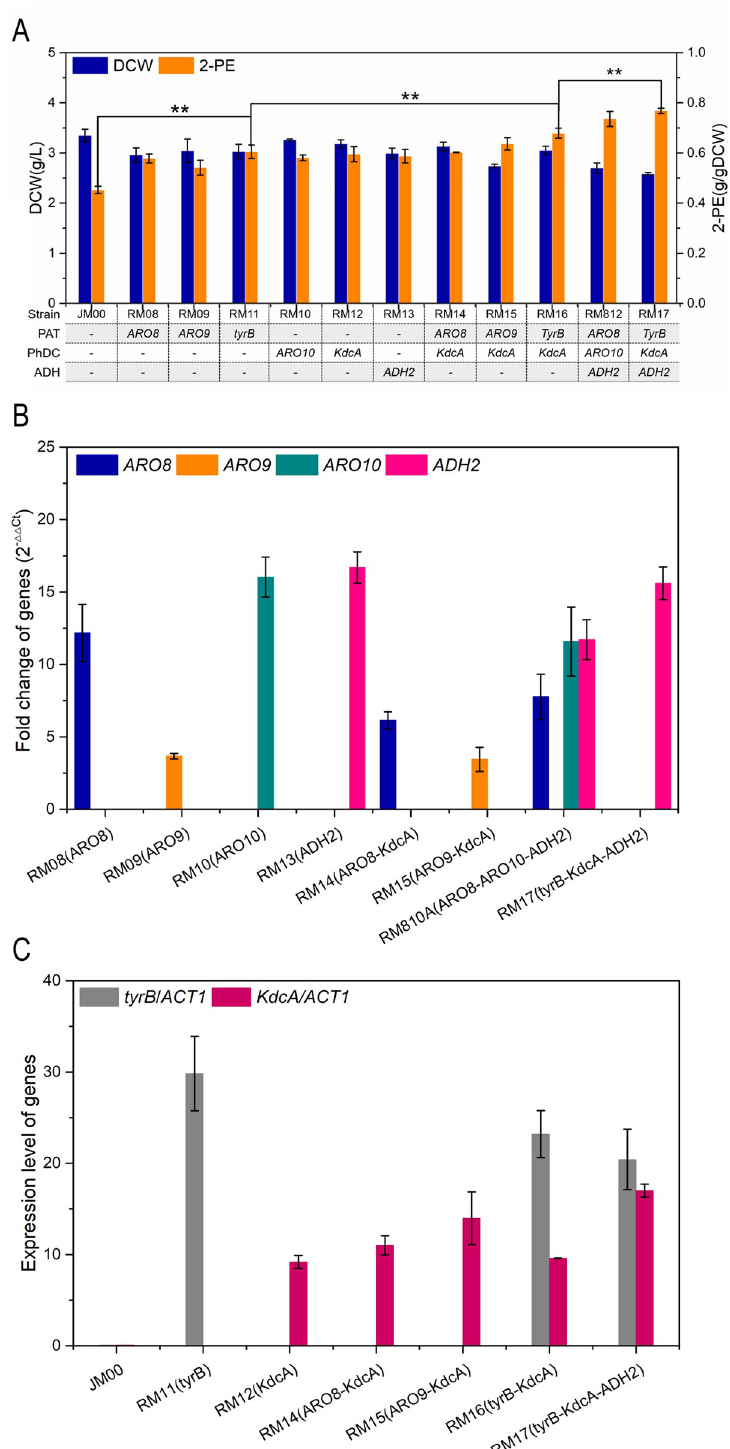
Fig 4. Effective expression of individual key enzyme and fusion protein in Ehrlich pathway. (A) Influence on cell growth and 2-PE production by overexpressing enzymes of Ehrlich pathway respectively. The gene types were listed under the bar graph. Enzyme abbreviations: PAT, phenylalanine transaminase; PhDC, phenylpyruvate decarboxylase; ADH, alcohol dehydrogenase. The mutant strains were cultured in YSM light medium (4 g/L phenylalanine) for flask fermentation. (B) Gene ARO8 , ARO9 , ARO10 and ADH2 transcription levels in the mutant strains. (C) Gene tyrB and